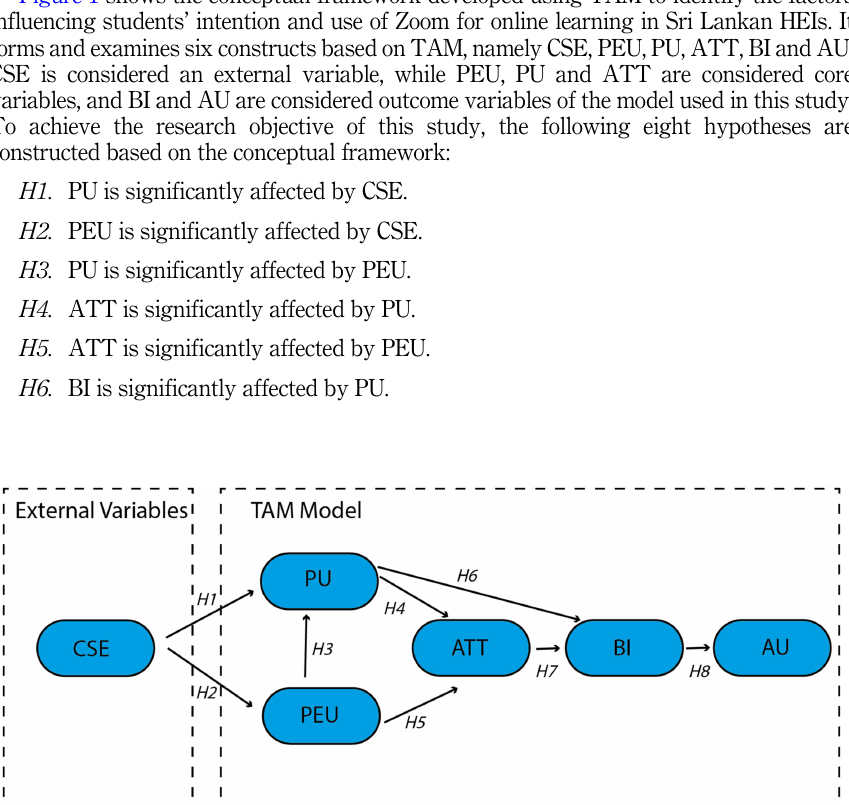
Figure 1. Conceptual